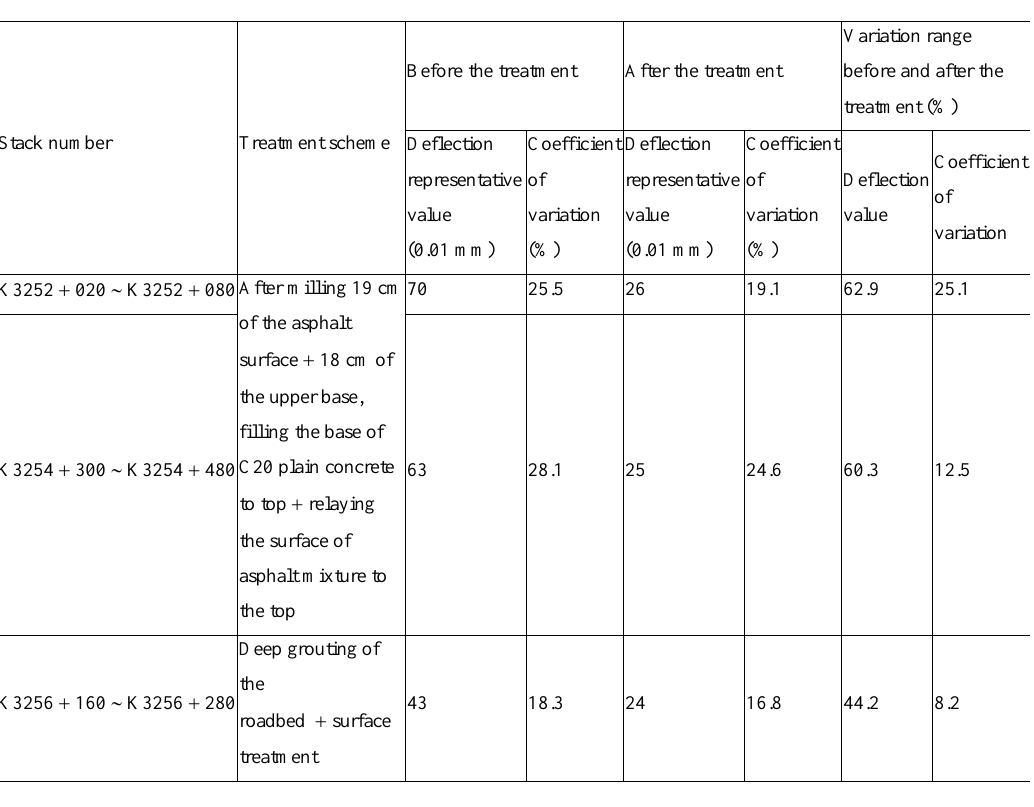
Variation range Before the treatment After the treatment before and after the treatment (%) Deflection Coefficient Deflection Coefficient Coefficient representative of representative of Deflection of value variation value variation value variation (0.01 mm) (%) (0.01 mm) (%)